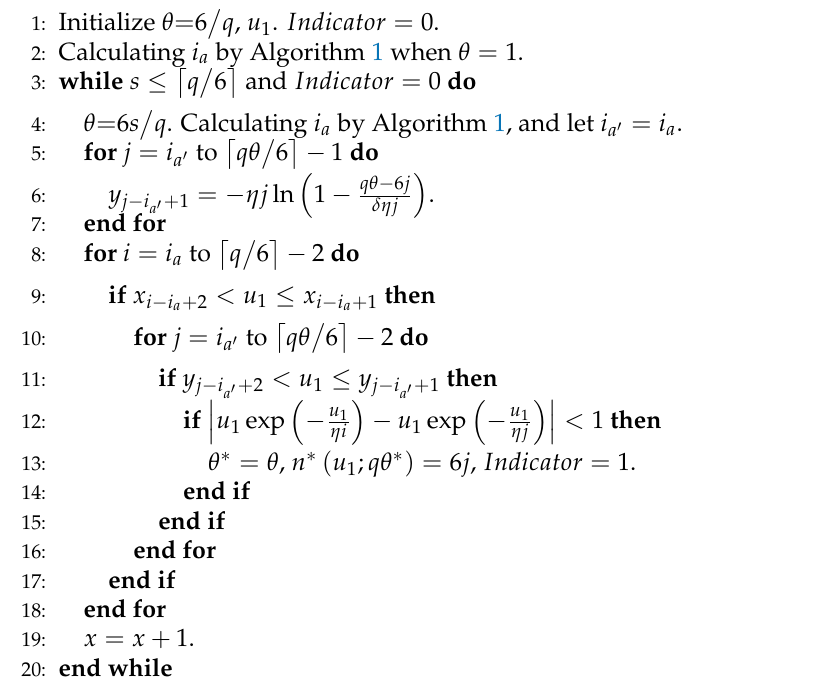
Algorithm 2 Optimal RBs allocation factor between NCAS and